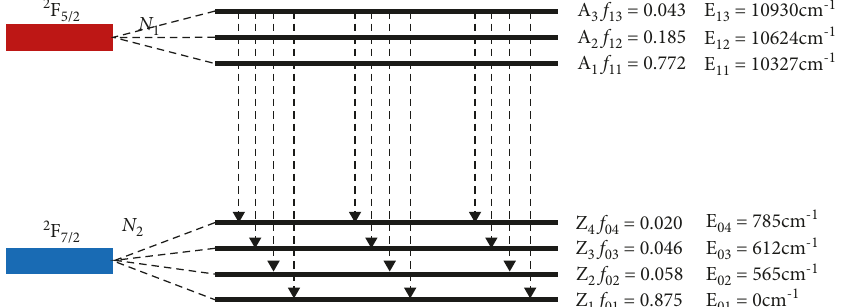
Figure 4: Yb: YAG energy level diagram at 300 K [13].